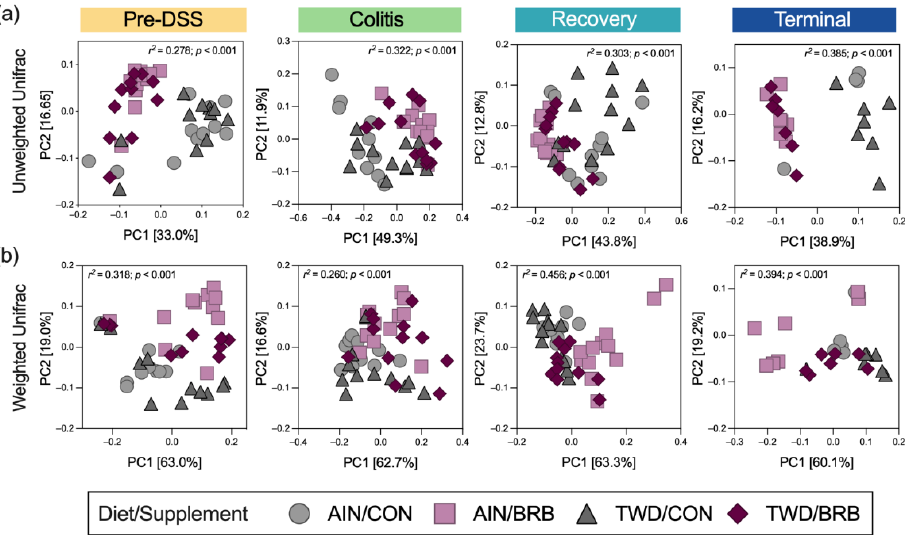
Figure 12. Beta diversity of mouse fecal microbiomes for each experimental time point (experiment B). Principal coordinate plots depicting fecal microbiome beta diversity using ( a ) unweighted or ( b ) weighted unifrac distances are shown using the first two components. The variations attributed to PC1 and PC2 are shown along with the r 2 and permanova p -values for each plot.